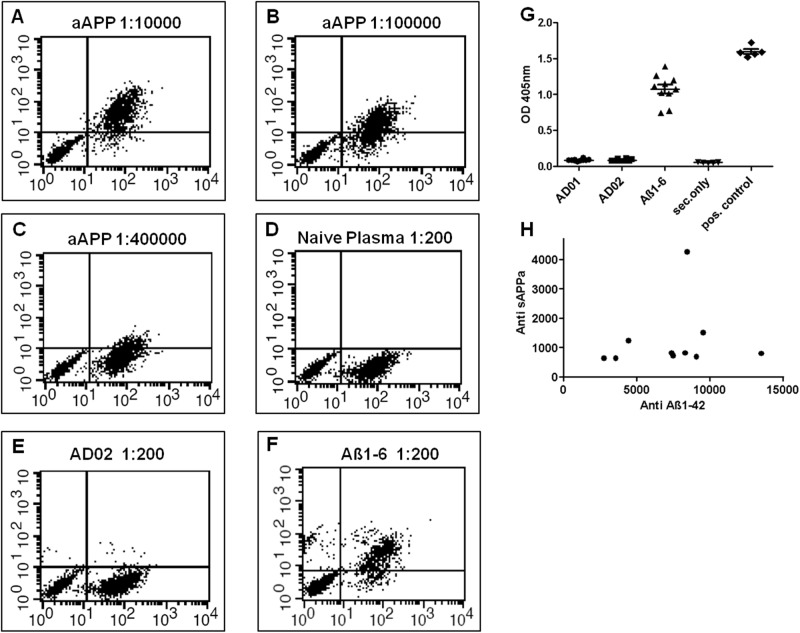
AFFITOPE induced Antibodies spare APP and sAPPa.Mice were s.c. injected 3 times at a 2-week interval with AD01-, AD02- or Aß1-6-conjugate vaccines adjuvanted with ALUM. Plasma was taken at sacrification. A-D depict controls for full length APP-specific FACS analysis using the APP-specific mAb mP2-1 (A-C) or naïve plasma (D); E and F show two exemplaric analyses of AD02 and Aß1-6 induced plasma in this assay. G and H depict analysis of immune responses against sAPPa following vaccination (n = 10 animals/treatment group) by peptide ELISA. For analysis of the presence of APP specific antibodies, the % of cells shifting in the non-APP expressing population and the % of cells shifting in the presence of the secondary antibody only were subtracted from the % of APP-positive cells shifting as indicator of APP binding. The assay threshold was set to 5%. Positive controls (A-C) show an Ab dose dependent (LOD of ≤1ng/ml mAb) shift of the APP positive but not of the APP-negative population. No reactivity was seen with plasma from naïve animals (D). AD02-induced samples show no reactivity to the APP-positive as well as APP-negative populations (E) whereas Aß1-6 induced sera show a specific shift at a dilution of 1/200 in the APP-positive cell population (upper right quadrant) with only very limited reactivity to the non-APP expressing cell population (lower and upper left quadrant; F). Neither AD01 nor AD02 was found to elicit sAPPa-specific Abs (G). On the contrary, following Aß1-6 immunization, sera of all 10 animals were shown to cross-react with sAPPa (G). A correlation analysis for anti Aß1-42 and anti sAPPa reactivity of plasma samples from animals undergoing Aß1-6 immunization (H) fails to detect a significant correlation indicating a highly individual response against sAPPa (Pearson r = 0.1534; R²= 0.02354); Titers determined were calculated based on ODmax/2 values. aAPP…anti APP specific Ab, neg.contr… is secondary Ab only; AD01, AD02 is AD01- and AD02-vaccine induced plasma, Aß1-6 is Aß1-6 vaccine induced plasma, sec.only… secondary Ab only, pos. control…. mAb P2-1